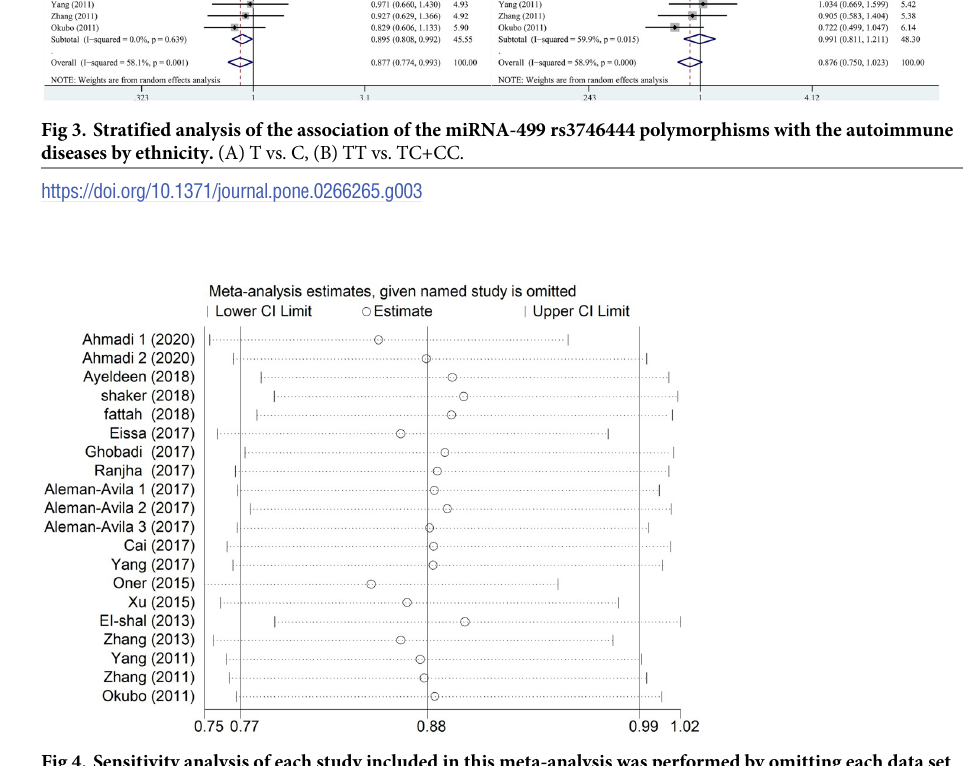
Fig 4. Sensitivity analysis of each study included in this meta-analysis was performed by omitting each data set from the analysis (T vs. C). analysis was performed to assess the relationship between miRNA-499 gene polymorphism and RA, SLE, UC, and BD. In RA studies, there was a significant association in some genetic models (TT vs. CC: OR = 0.553; 95% CI: 0.352, 0.870; P = 0.010; TT+TC vs. CC: OR = 0.607; 95% CI: 0.412, 0.894; P = 0.012). In SLE studies, the result show that there has been a marked association in dominant model(TT vs. TC+CC: OR = 0.762; 95% CI: 0.598, 0.985; P = 0.038). In UC studies, two contrast genetic models (T vs. C and TT vs. CC) showed statistically signifi- cant association with random effect model (T vs. C: OR = 0.802; 95% CI: 0.685, 0.938; P = 0.006 TT vs. CC: OR = 0.603; 95% CI: 0.390, 0.933; P = 0.023). In BD studies, four contrast genetic models (T vs. C, TC vs. CC, TT vs. CC and TT+TC vs. CC) showed statistically signifi- cant association with random effect model(T vs. C: OR = 1.527; 95% CI: 1.126, 2.073; P = 0.007 TC vs. CC: OR = 2.551; 95% CI: 1.440, 4.520; P = 0.001 TT vs. CC: OR = 2.794; 95% CI: 1.380, 5.657; P = 0.004 TT+TC vs. CC OR = 2.605; 95% CI: 1.494, 4.540; P = 0.001)(Table 4 and Fig 6).